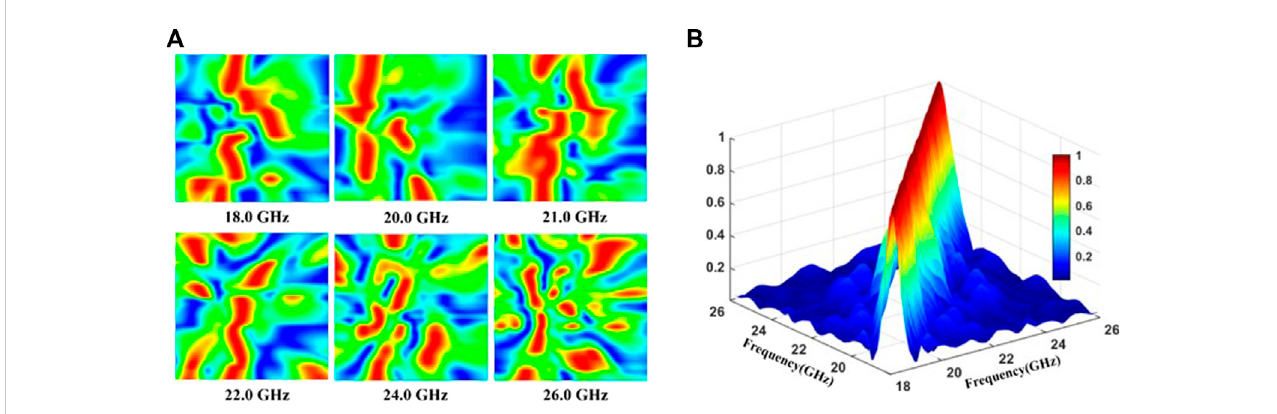
FIGURE 3 (A) Measured 2-D patterns of FDHM antenna at different frequencies. (B) 2-D pattern correlation between different